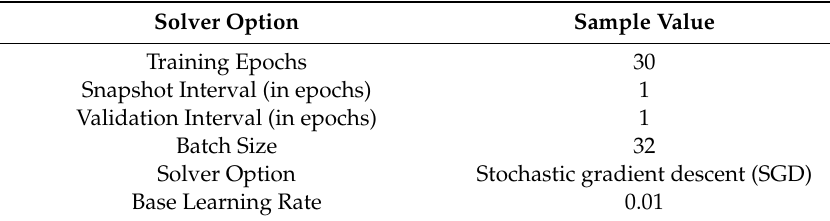
Table 3. Solver options used to optimize